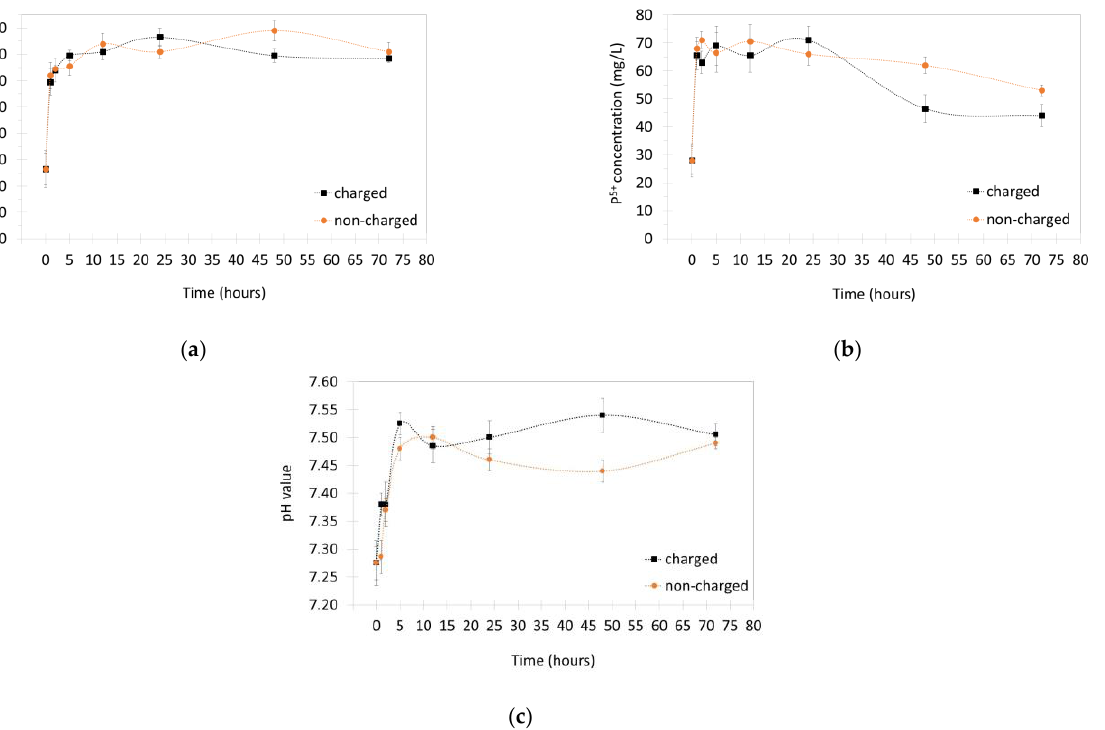
Figure 5. The variation of the Ca 2+ ( a ) and P 5+ ( b ) ionic concentrations and of the pH value ( c ) for increasing immersion times in the SBF solution (0, 1, 3, 6, 12, 24, 48 and 72 h), for the charged and non-charged samples. The first value at 0 h is equal for both samples, matching the initial concentrations and pH value of the SBF solution.